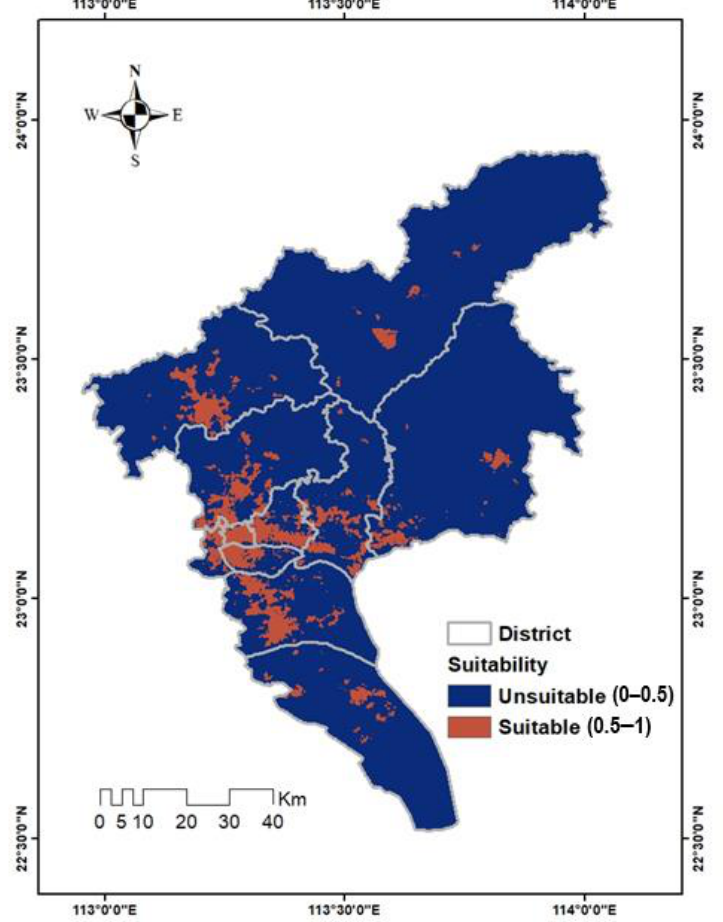
Figure 5 . Suitability map for PPLs using the best LR model. Figure 5. Suitability map for PPLs using the best LR